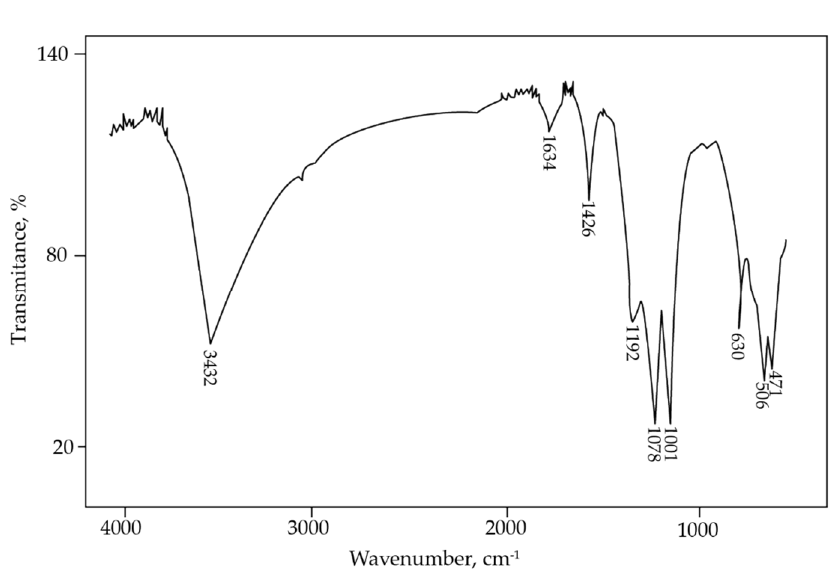
Figure 5. FTIR spectrum of jarosite-PbAg sludge. Size distribution data of dried jarosite-PbAg sludge sample obtained from laser diffraction measurements are plotted as a particle and cumulative size distribution and shown in Figure 6. It is shown that the median diameter of particles is 1.58 µm.